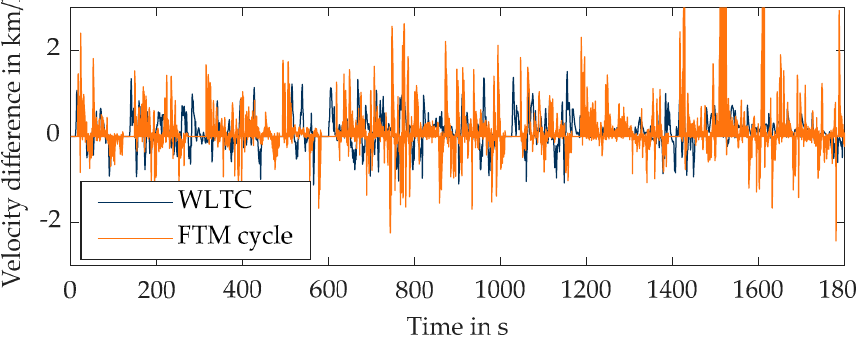
Figure 4. Differences between the driving cycles and the actual driven vehicle velocity.